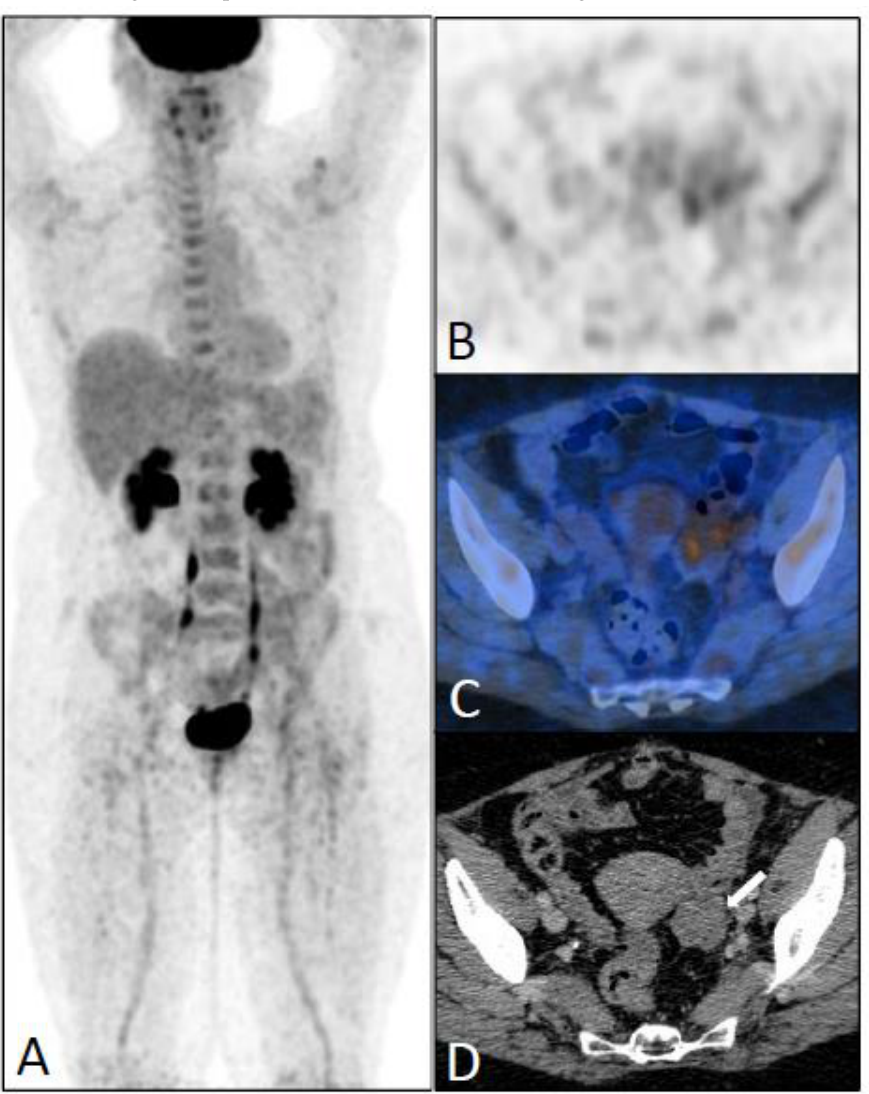
Figure 5. An FDG-PET/CT scan performed eight years after the initial diagnosis of ILC (pT3N1, SBR II) in a 55-year-old patient, due to elevated tumor marker (CA 15.3 = 249). Maximum intensity projection ( A ), Axial PET ( B ), and PET/CT fusion ( C ) images showing a faintly increased FDG uptake not described in the report. A left uterine mass (white arrow) associated with a peritoneal effusion was found on a CT scan ( D ) performed one week after the PET/CT scan. Peritoneal and ovarian metastases were confirmed by laparoscopy and chemotherapy was introduced. This patient died from disease progression in the peritoneum nine years after the diagnosis of recurrence.